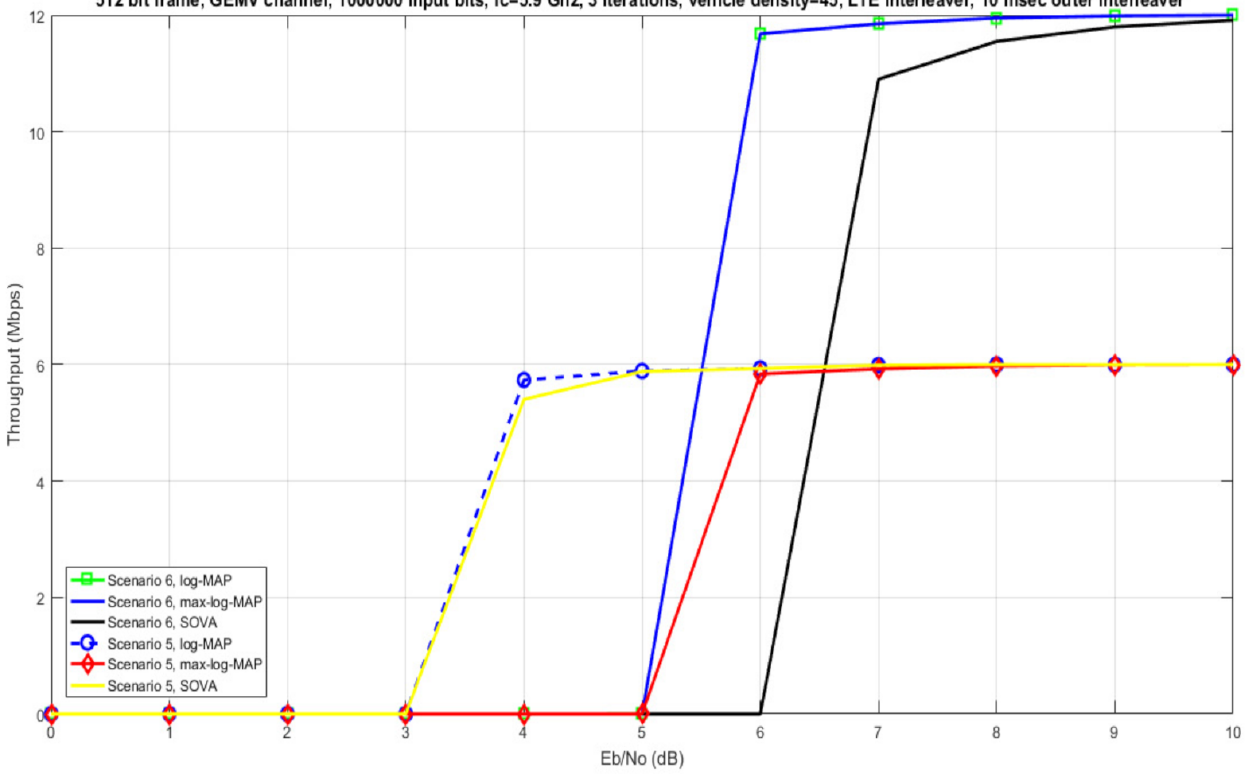
Figure 11. Throughput vs. SNR for scenarios 5 and 6 of Table 2, considering different decoding algorithms, 3 iterations, frame length of 512